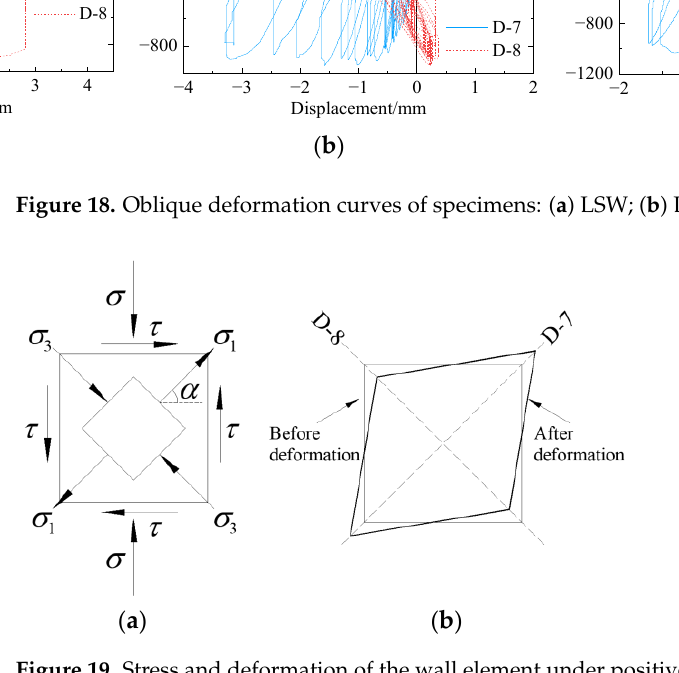
Figure 19. Stress and deformation of the wall element under positive loading: ( a ) element stress; and ( b ) element deformation.